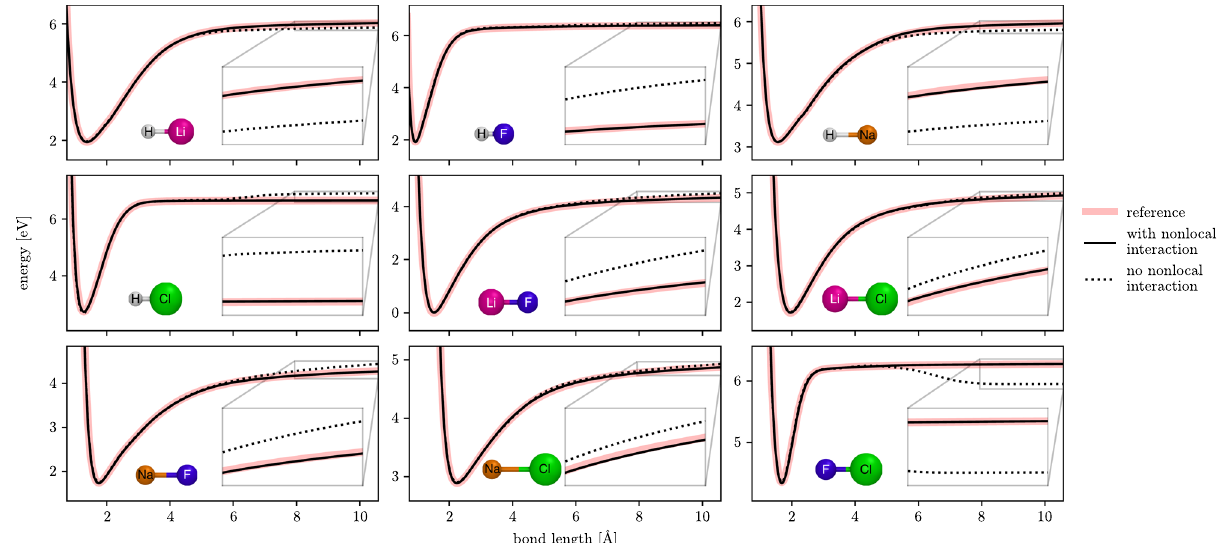
Fig. 5 Dissociation curves of different diatomic molecules predicted by SpookyNet with/without nonlocal interactions. Individual panels show the dissociation curves for different species. From top-left to bottom/right: HLi, HF, HNa, HCl, LiF, LiCl, NaF, NaCl, and